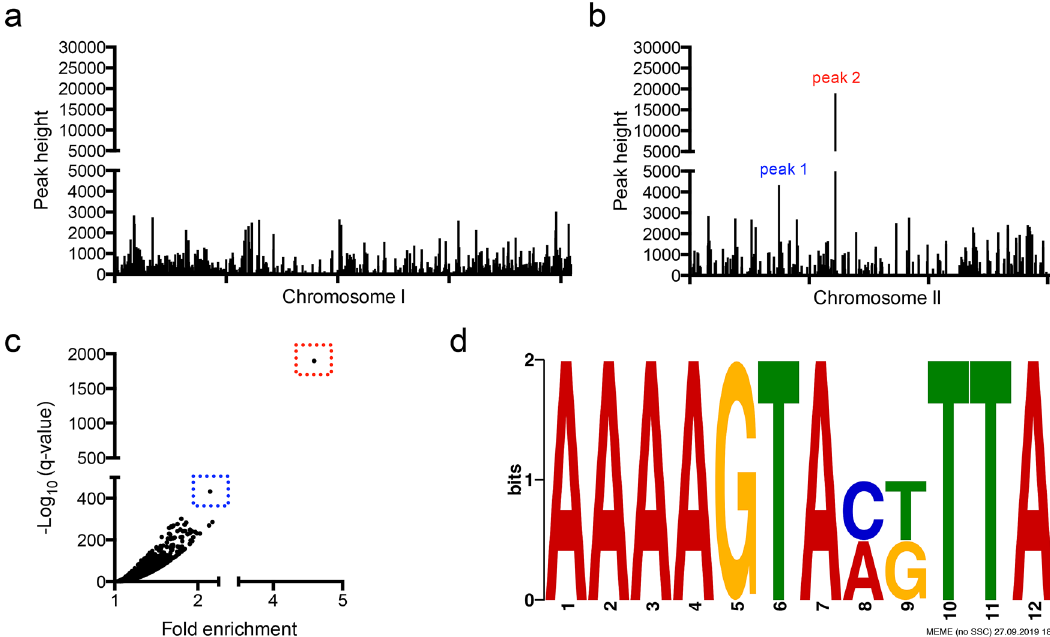
Figure 5. ChIP-seq identifies two regions of BP1026B_II1198 binding on chromosome II. Peaks identified using MACS2 76 by comparison to an empty vector negative control are plotted by peak height and genome position on chromosome I (a) and chromosome II ( b ). ( b ) Two peaks were identified on chromosome II and are labeled as peak 1 in blue and peak 2 in red. ( c ) The two identified peaks are further isolated from background when compared by statistical (-log 10 q-value) and fold enrichment. Blue box shows peak 1 and red box shows peak 2. ( d ) Potential binding motif identified by analysis of peak 1 and peak 2 nucleotide sequences by MEME 38 . Each peak contains the same orientation of the potential binding